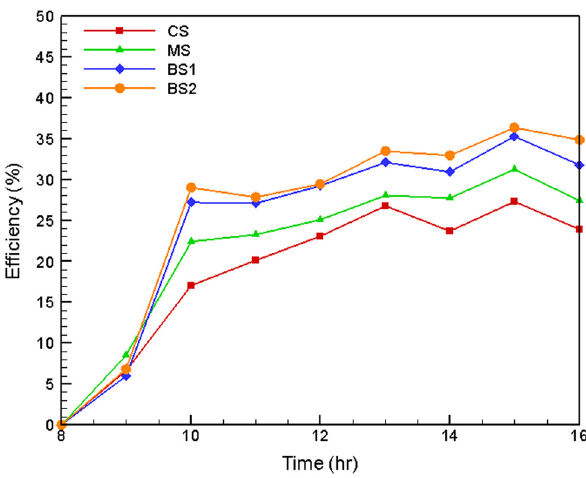
Figure 16: Variation of the thermal e ffi ciency with time.